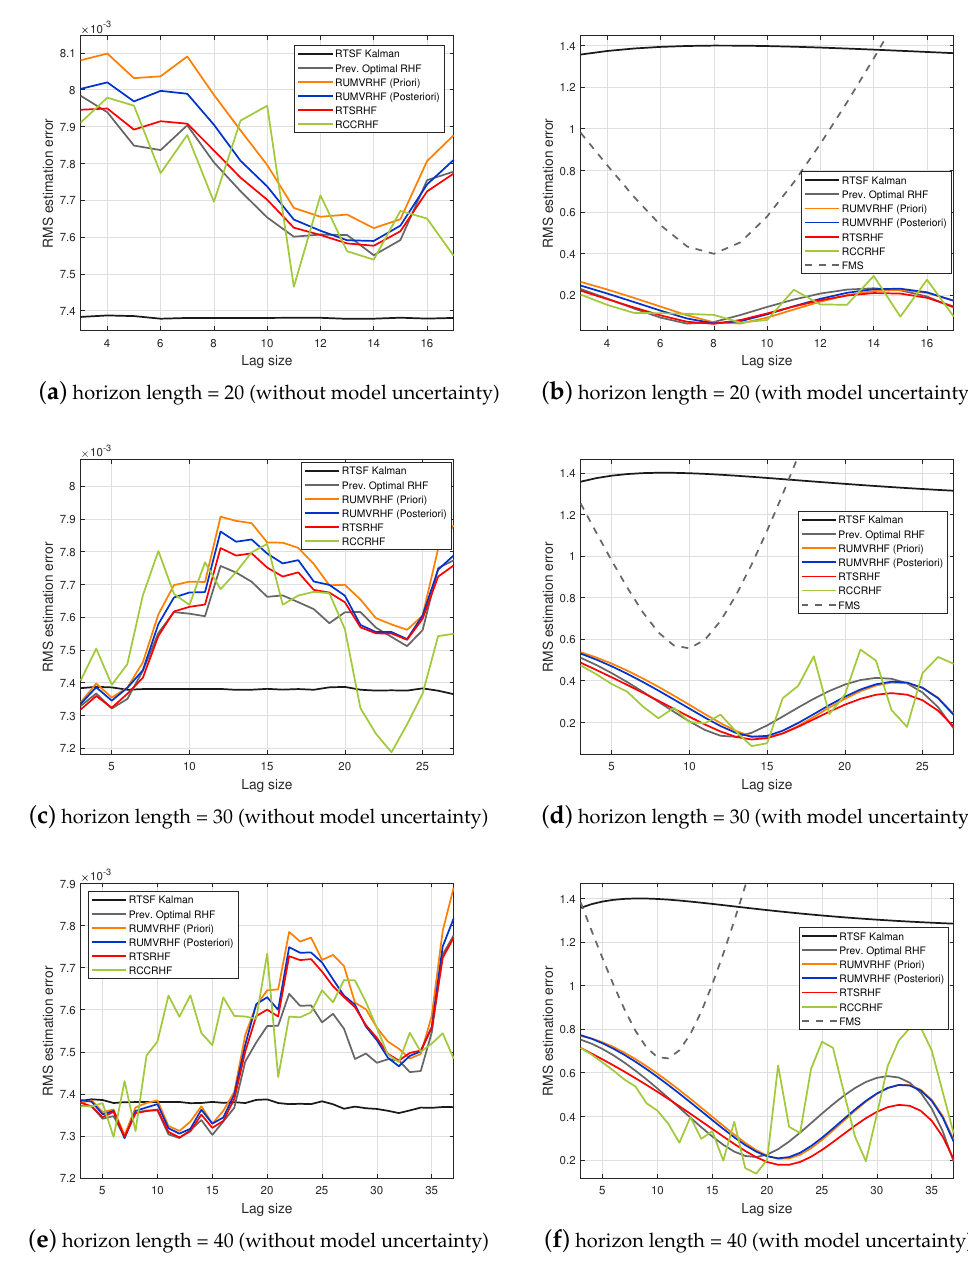
Figure 6. RMSE errors with respect to the various horizon lengths and lag